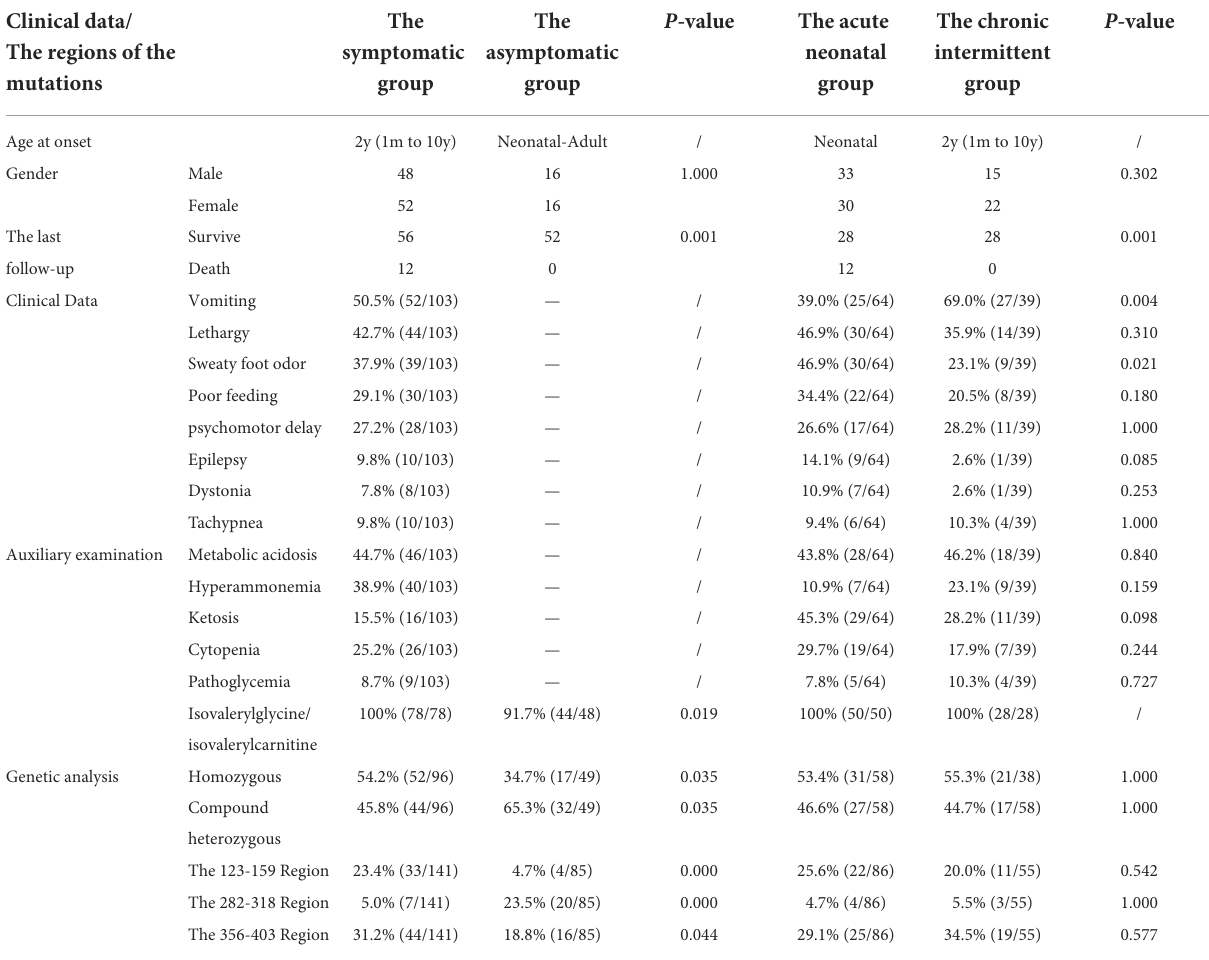
TABLE 2 The clinical characteristics of 155 patients with isovaleric acidaemia (IVA). Clinical